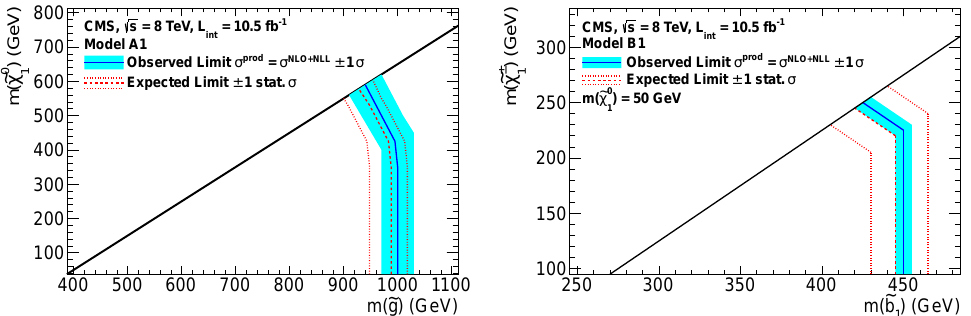
) vs m ( (cid:101) g ) plane, where each of the gluinos decays (cid:101) g → t ¯ t (cid:101) χ 0 1 ) vs m ( (cid:101) b ) plane, for a model with sbottom pair production. 1